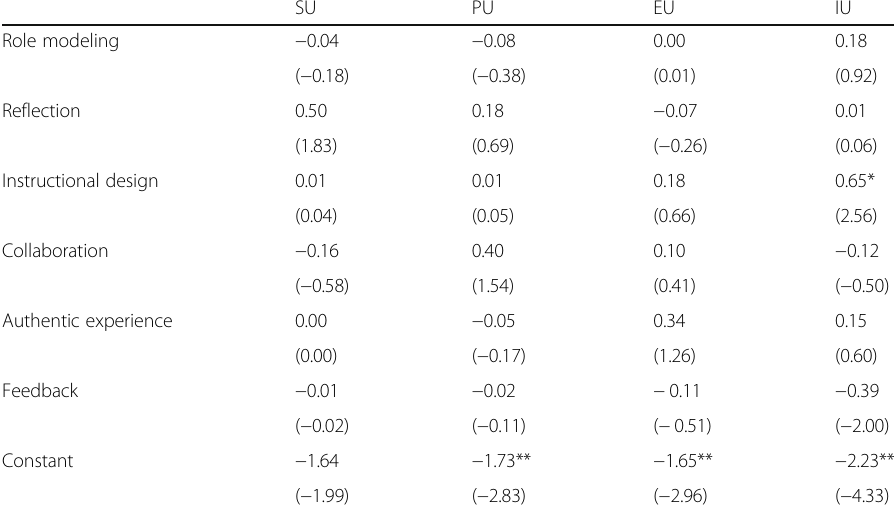
Table 7 Effect Sizes of Training Components on Technology Adoption SU PU Role